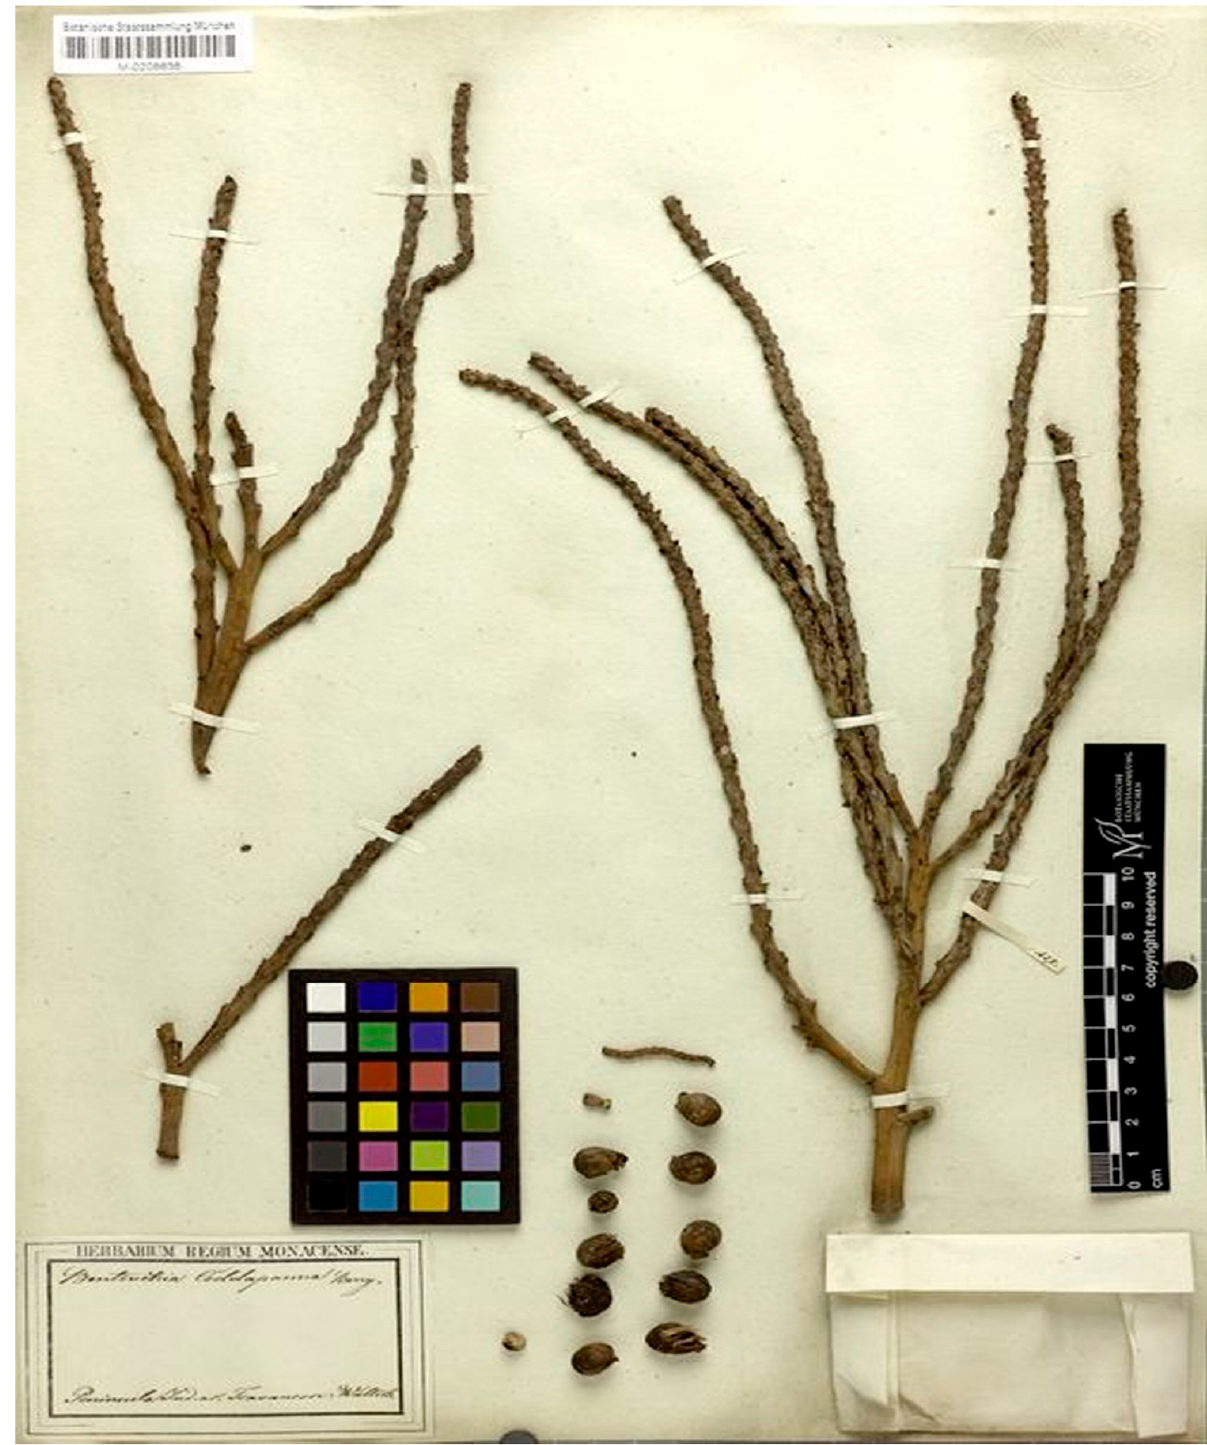
Figure 7. Neotype of Bentinckia condapanna Berry ex Roxb. (M0208636). © Botanische Staatssammlung München (M).